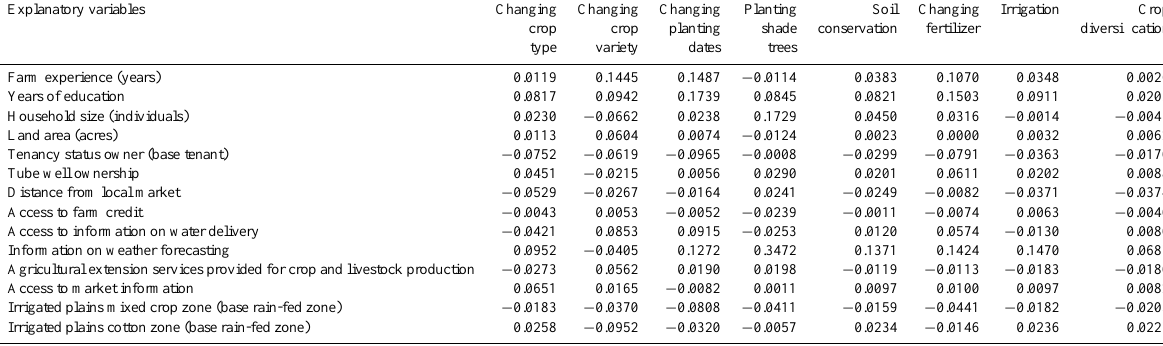
Table 6. Elasticity calculations of the binary logistic models of farm-level adaptation measures. Explanatory